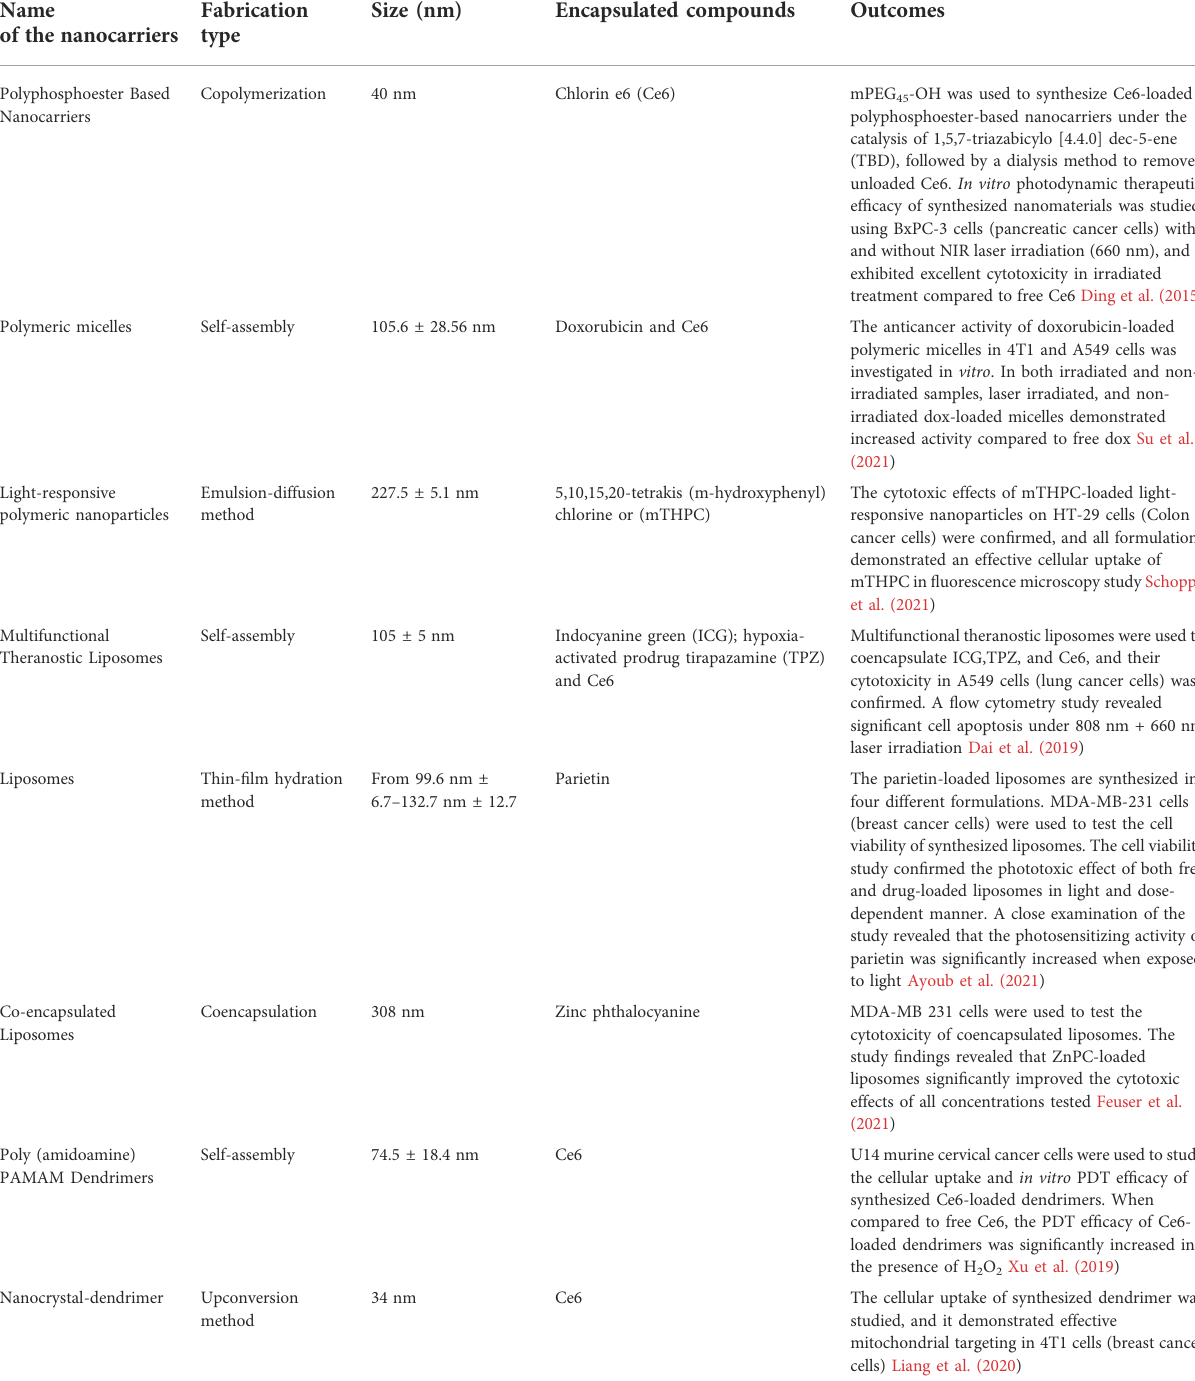
TABLE 1 Different types of biocompatible nanocarriers used for cancer PDT in vitro